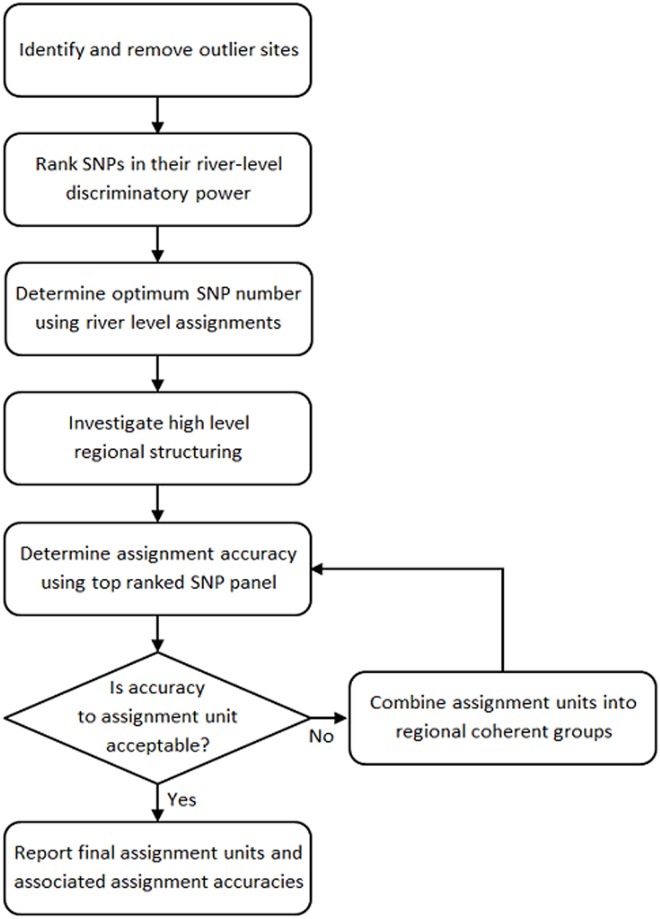
Steps taken in defining assignment units and accuracy of assignment to the units identified.